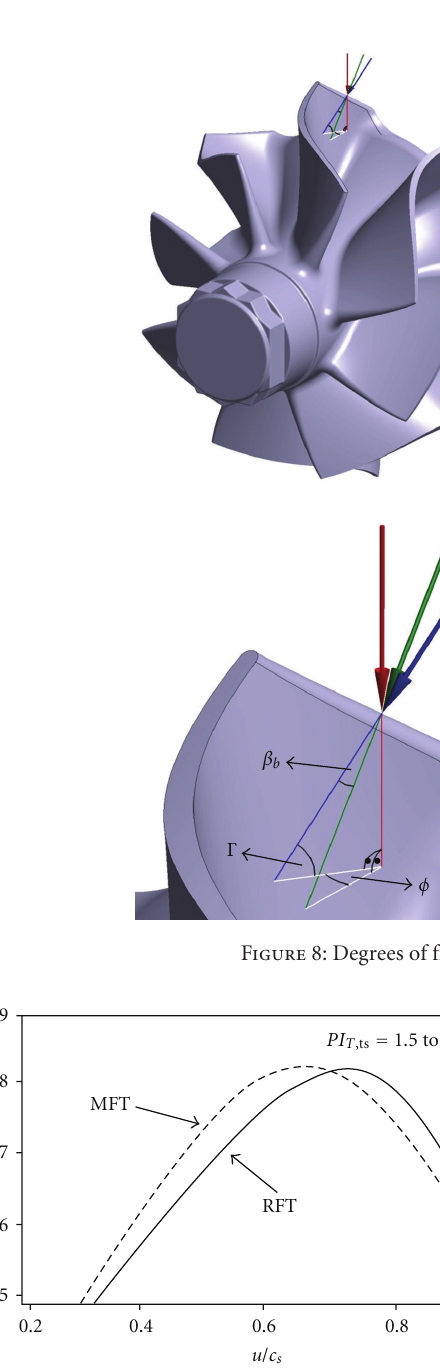
Figure 9: Turbine e ffi ciency as a function of blade speed ratio for radial and mixed flow turbines